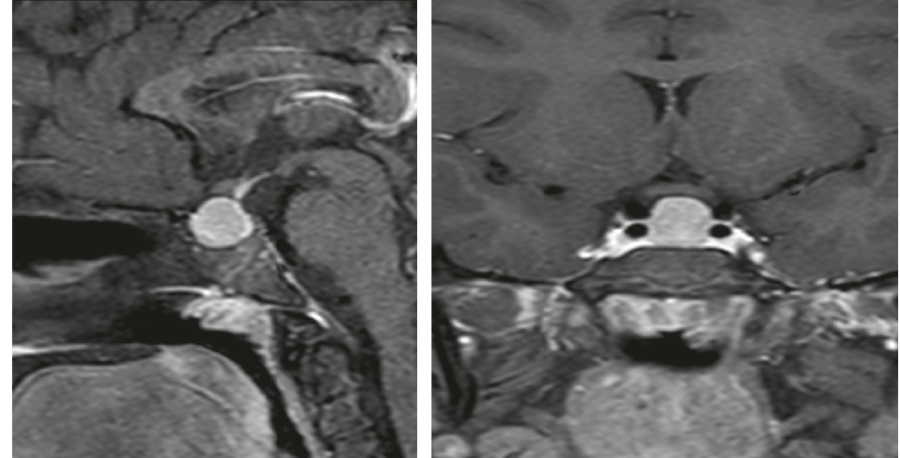
Figure 3: Sagittal and coronal contrast-enhanced T1-weighted magnetic resonance images taken at presentation. The images showed a homogenously enhancing solid mass arising from the pituitary gland with a superior concave border abutting the optic chiasm. There was no cystic/necrotic, haemorrhagic, or calcific